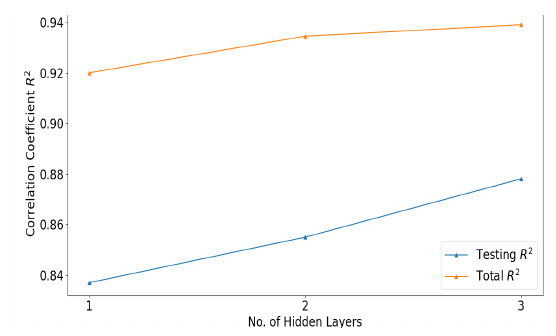
Figure 8. R 2 values obtained from brute-force method for torque modelling